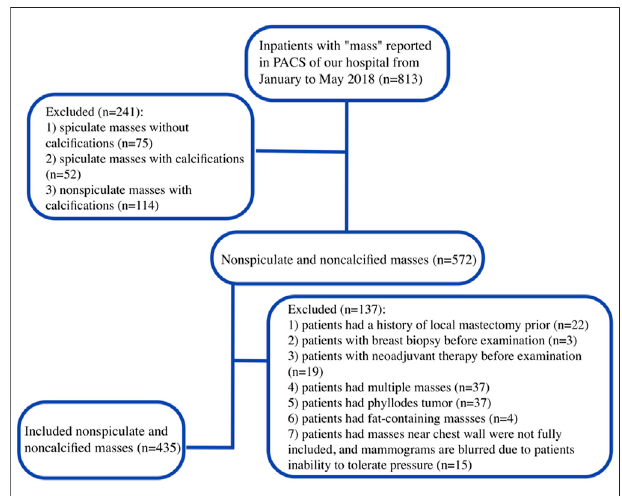
FIGURE 1 | Flowchart shows the process of enrolling patients in this